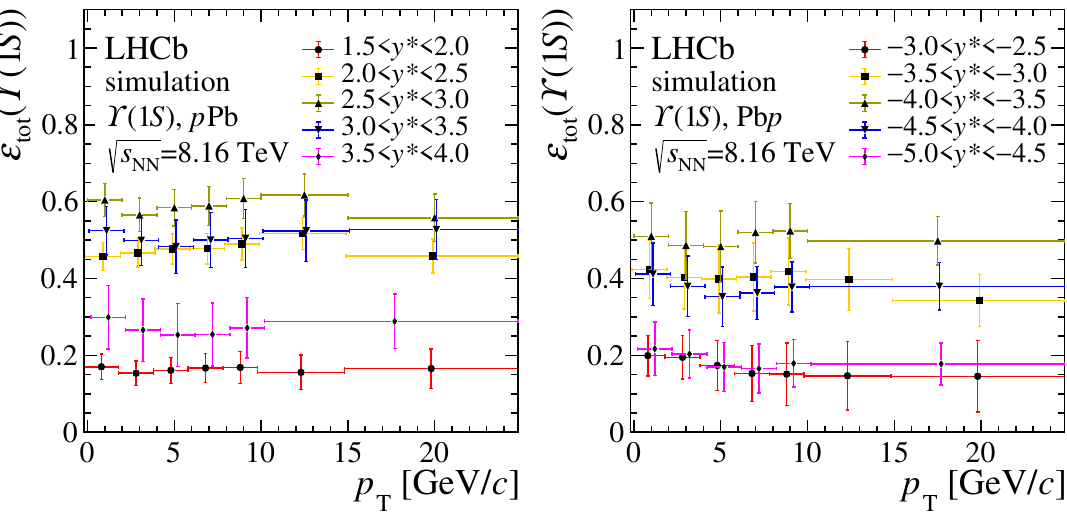
Figure 2 . Total e(cid:14)ciency " tot of the (cid:7) (1 S ) meson as a function of its p T in di(cid:11)erent y (cid:3) bins in (left) p Pb and (right) Pb p collisions. The horizontal locations of the markers are roughly the centroids of the bins, with o(cid:11)sets from centre to aid in